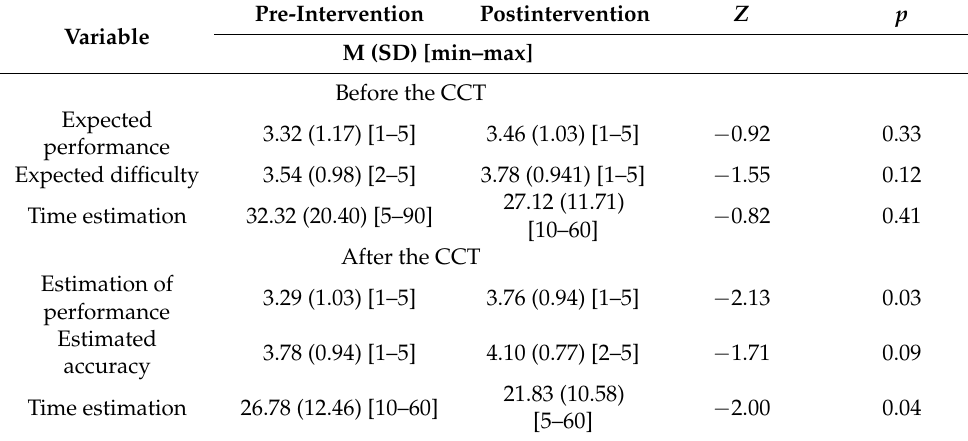
Table 3. Comparison of pre- and postintervention Children’s Cooking Task (CCT)